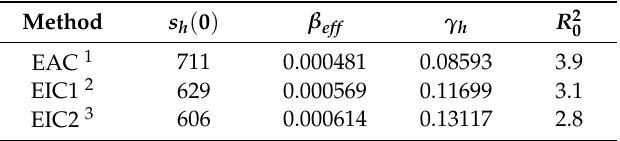
Table 4 . Model parameter estimates for Madrid-Spain. Table 4. Model parameter estimates for